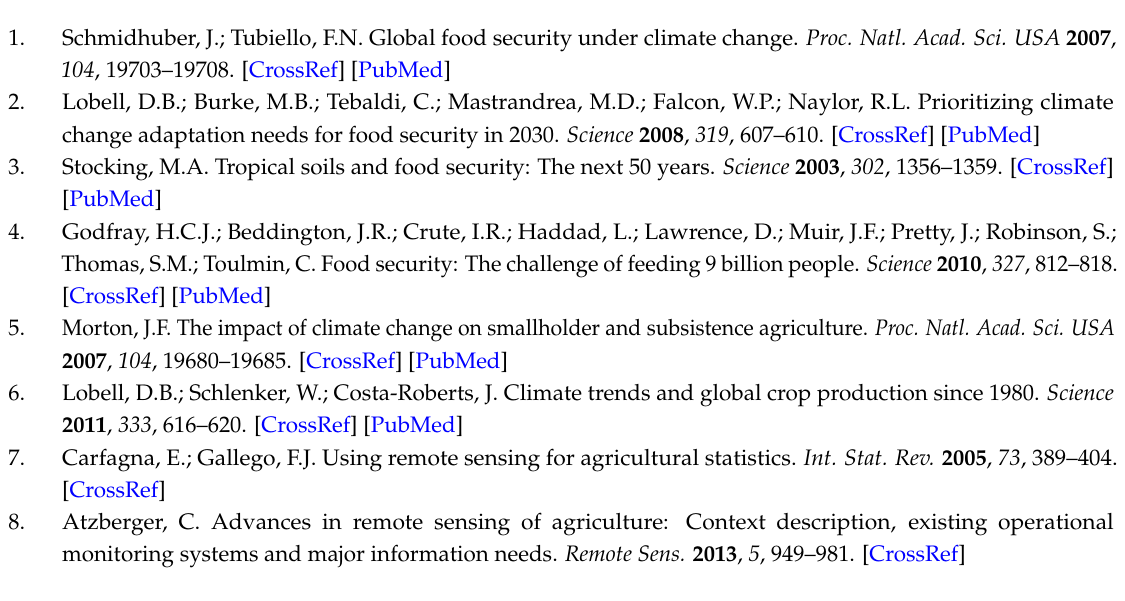
Table S1: Mask classification accuracy; Table S2: Crop model parameters used to run APSIM models; Table S3: Correlation of mean GCVIs; Figure S1: Scatterplots of GCVI versus sow date in 2014–2015; Figure S2: Scatterplots of GCVI versus sow date in 2015–2016; Figure S3: GCVI phenologies for early vs. late sown plots and low vs. high yield